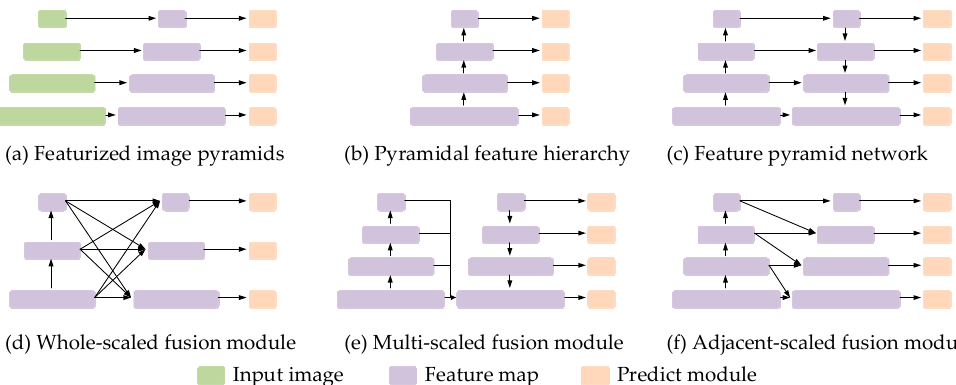
Figure 1. ( a ) Extracting feature pyramids from image pyramids, which is an inefficient way. ( b ) Performing detection on a pyramidal feature hierarchy generated from a convolutional neural network (ConvNet), like the single shot multibox detector (SSD) [4]. ( c ) Top-down feature fusion methods adopted by [5,6]. ( d ) Fusing whole-scale features in every scale, such as adaptively spatial feature fusion (ASFF) [7] and rainbow single shot detector (R-SSD) [8]. ( e ) Fusing multi-scale features for further extraction. ( f ) Our proposed feature fusion method. Only the adjacent-scale features up to the current layer are fused.